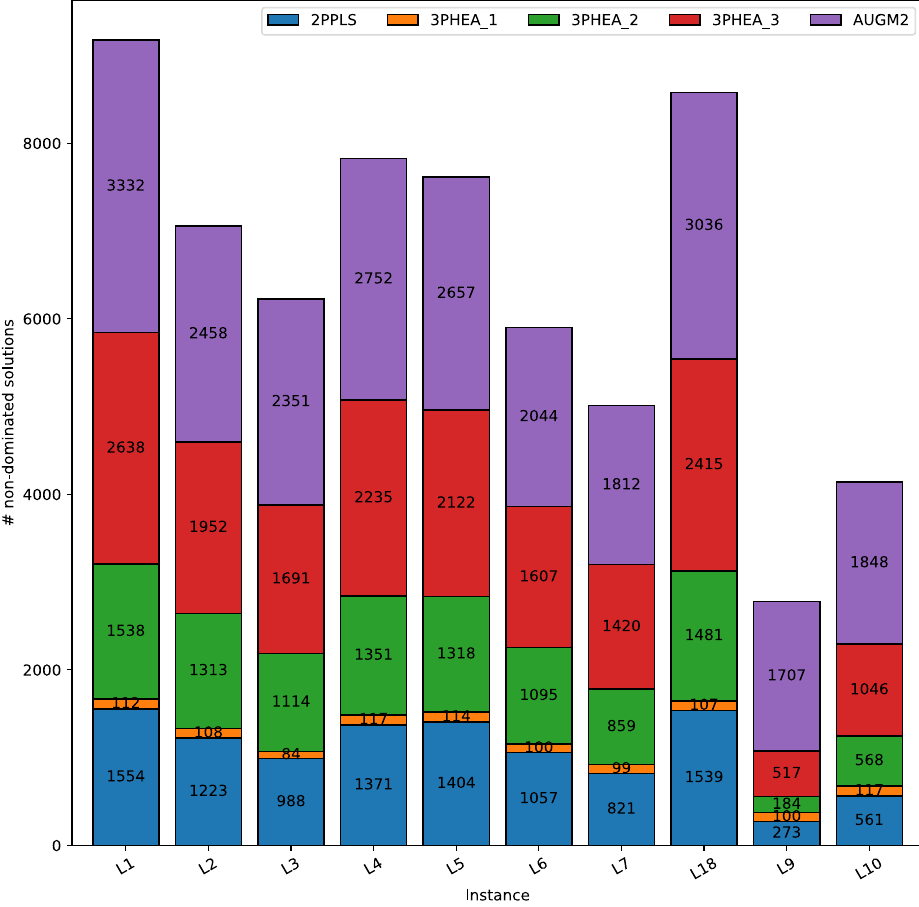
Figure 7. Distribution of coverage metric for datasets (Lust and Teghem 41